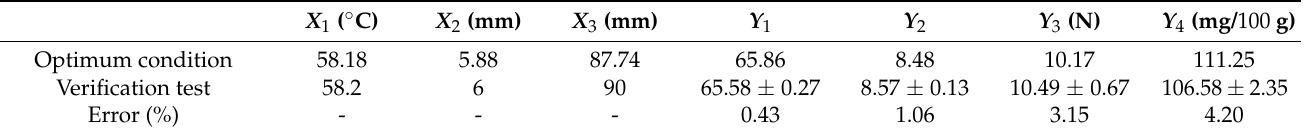
Table 7. Optimum conditions and verification